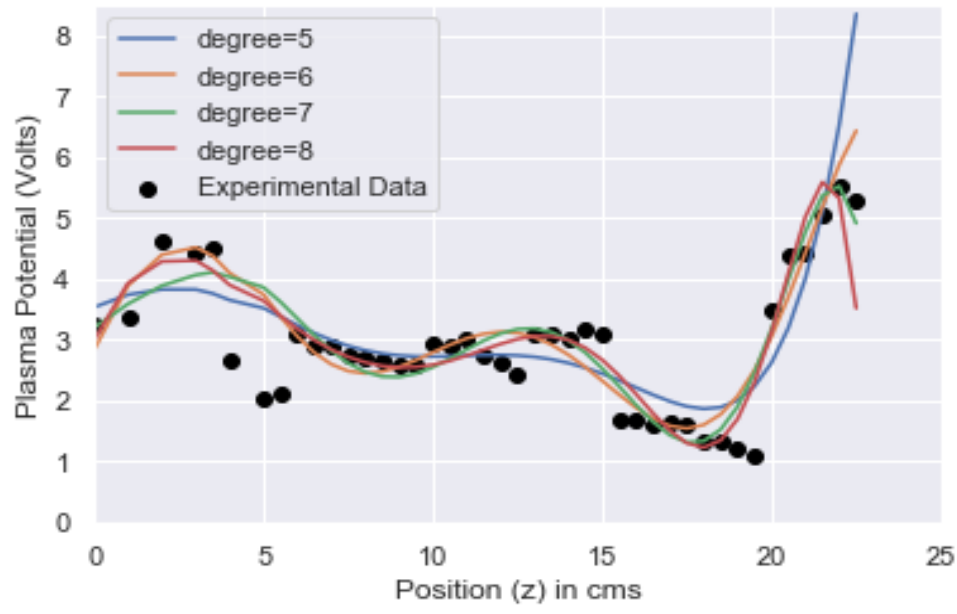
Figure 3. Prediction of axial variation of plasma potential using the polynomial regression model